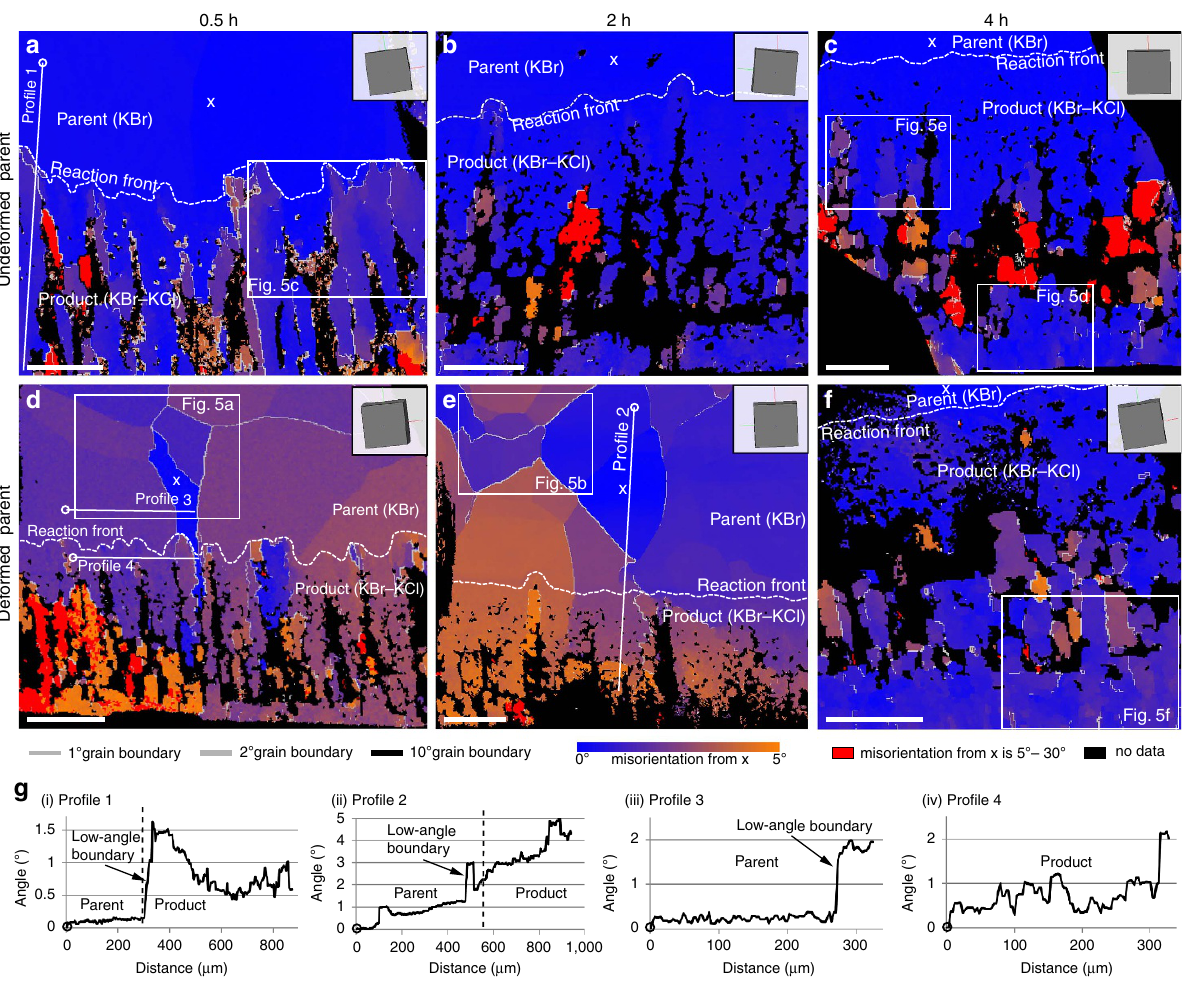
Figure 3 | Electron backscatter diffraction (EBSD) data. The scale bar on all images is 200 m m. Crystallographic misorientations in sample cross-sections from experiments with undeformed parent samples (set I) ( a – c ) and deformed parent samples (set II) ( d – f ) relative to the reference point x. The insets on the upper right of each EBSD map shows the physical orientation of the KBr crystal at the reference point x. ( g ) Misorientation angle variations across the profiles marked in ( a ), ( d ), ( e ). Starting point of each profile is marked with